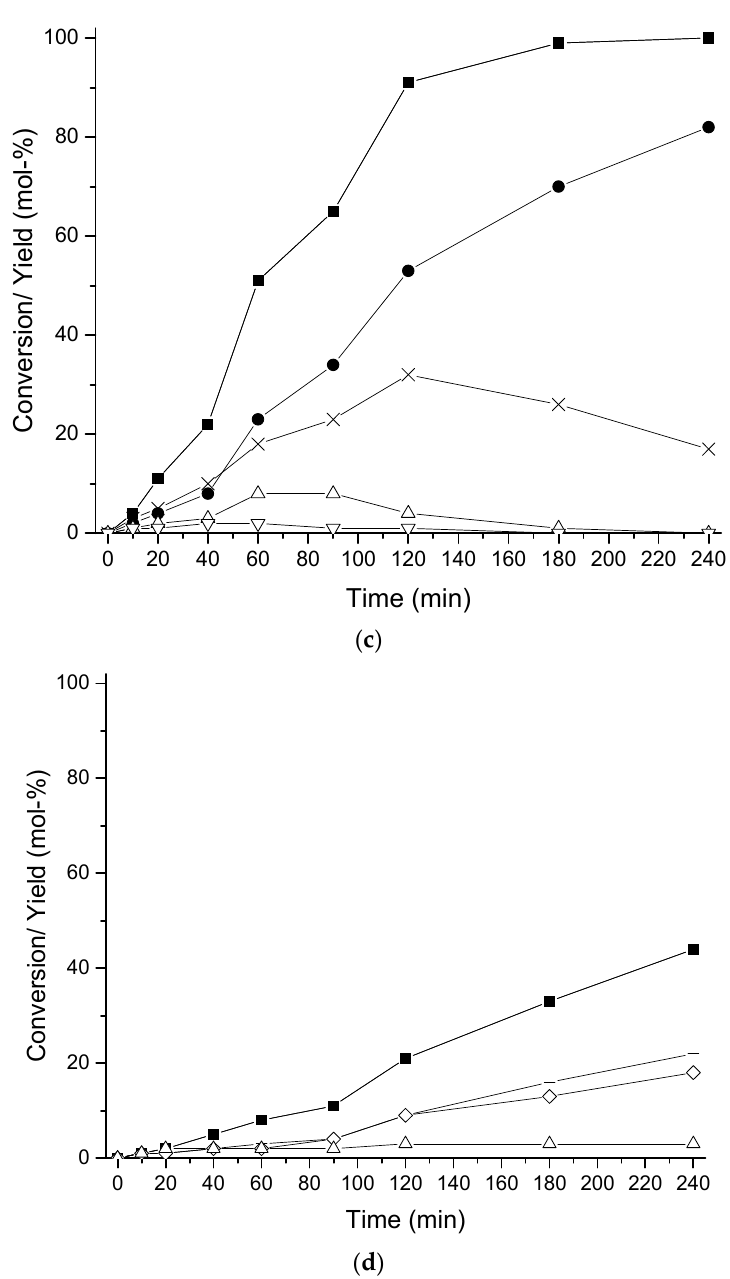
Figure 5. Comparative HDO of different model compounds over 10 wt % ReOx/CNF in dodecane at 300 °C under 5 MPa hydrogen adapted from reference [37], HDO of ( a ) guaiacol; ( b ) phenol; ( c ) anisole and ( d ) o ‐ cresol. Notation: ( ■ ) conversion, (+) phenol, (x) benzene, ( ◊ ) toluene, (o) cyclohexane, ( ▲ ) methoxycyclohexane, ( ) cyclohexanol, ( ) cyclohexene, ( ● ) lights.